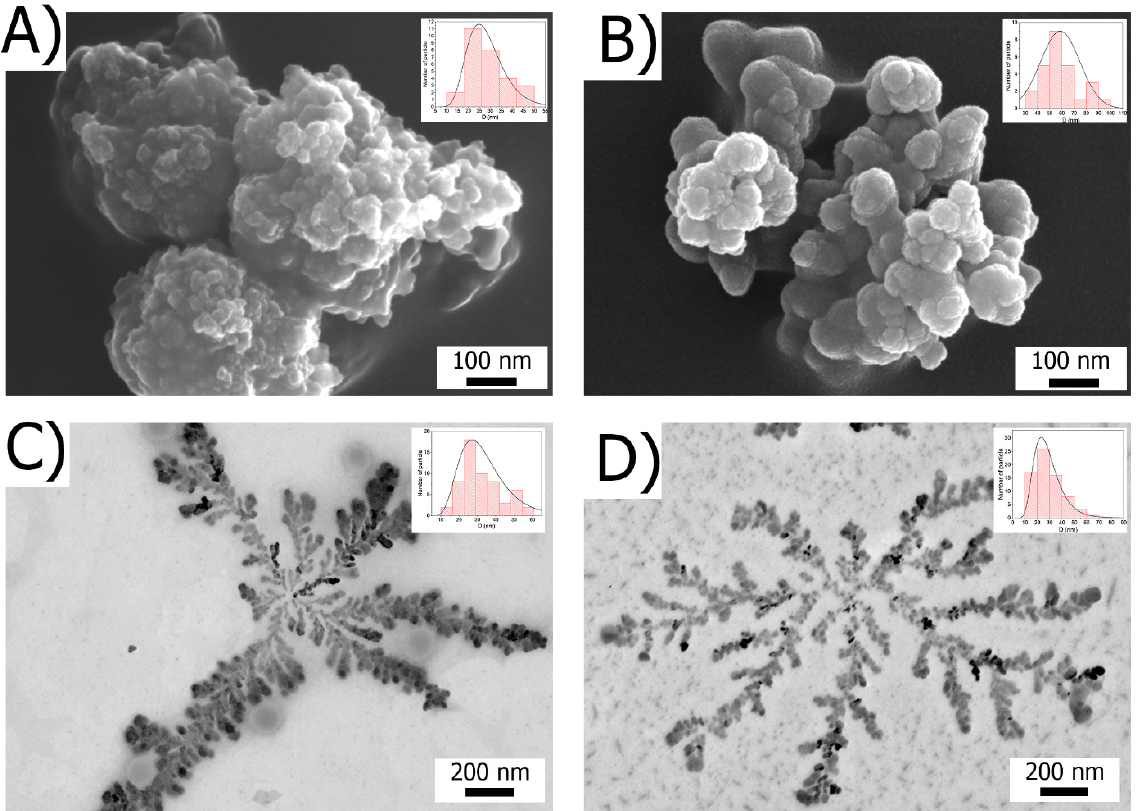
Figure 2. SEM images of particles ChemRed-NP ( A ), TermRed-NP ( B ), US/TermRed-NP ( C ), US-NP ( D ) with inserts of histogram of particle size distribution.